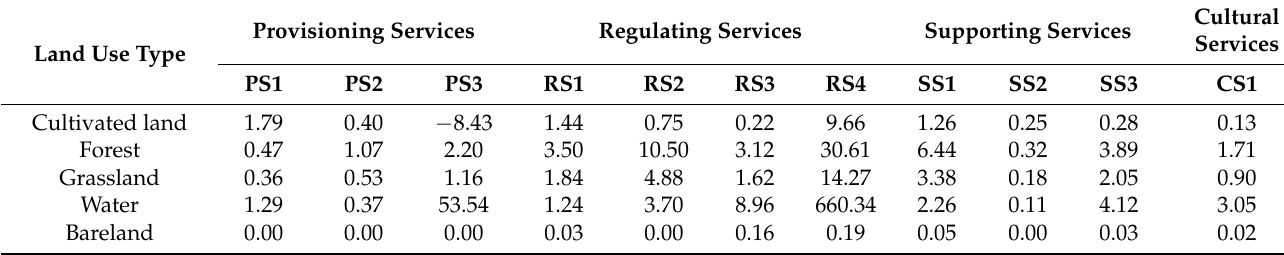
Table 3. Ecosystem service values equivalent table in Ruijin